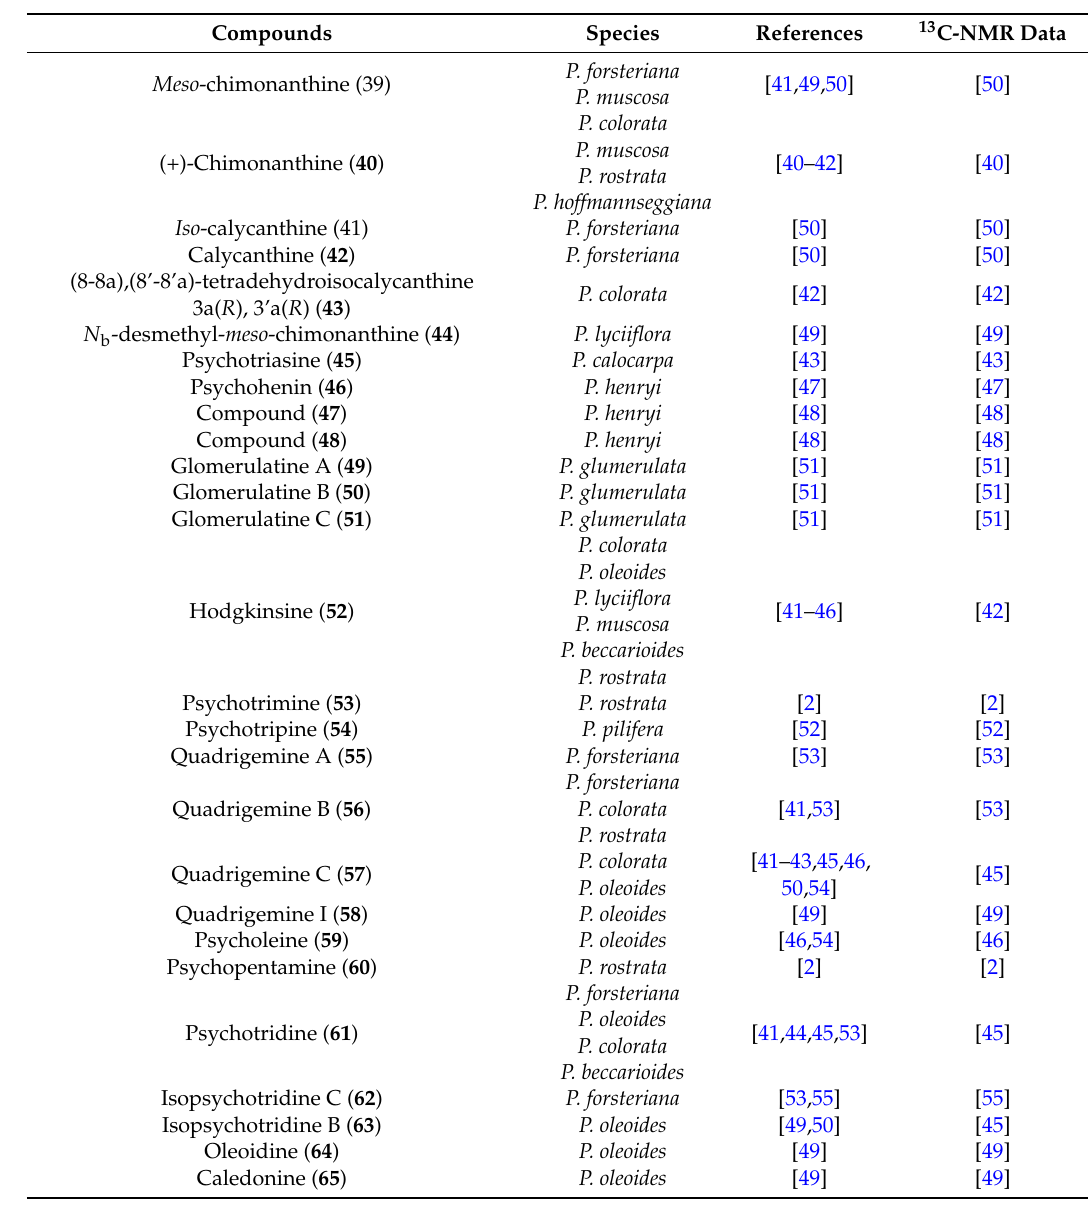
Table 3. Pyrrolidinoindoline alkaloids from Psychotria